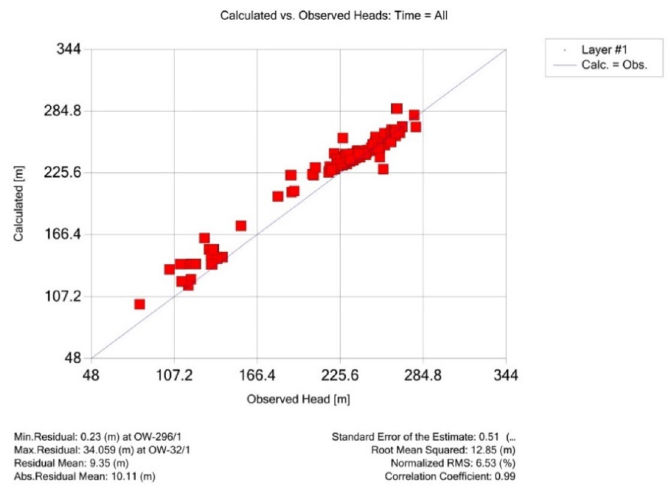
Figure 3. Visual MODFLOW (VMOD) output calibration chart comparing simulated and observed groundwater levels for all observation wells from 2013 to